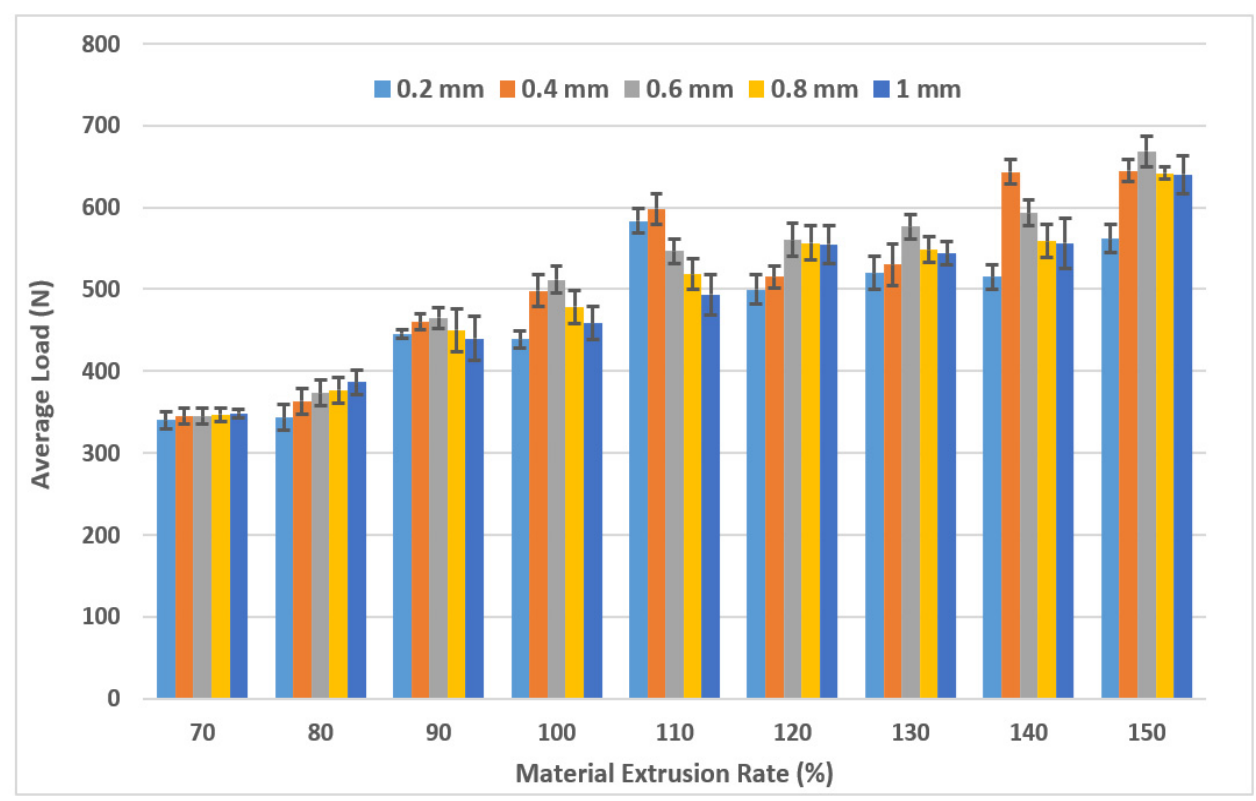
Figure 8. Results from three-point flexural testing.